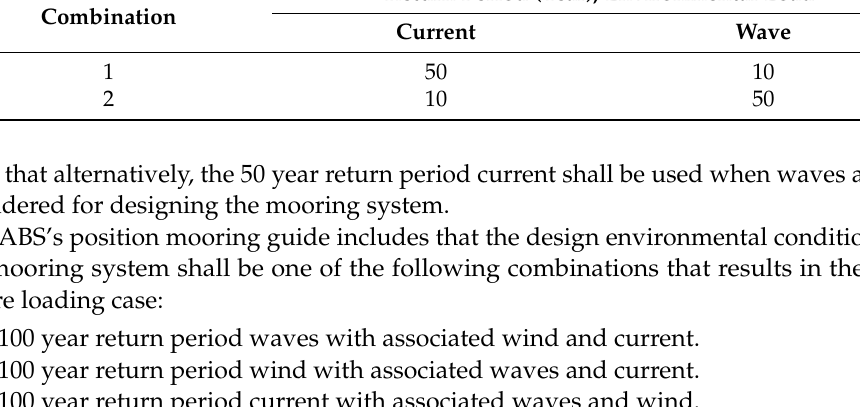
Table 9. Combinations of environmental loads for mooring systems from Scottish finfish aquaculture.